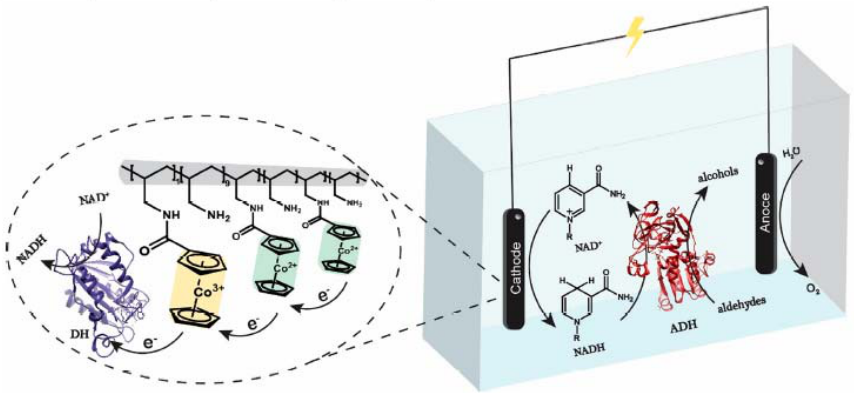
Figure 5. Schematic illustration of electro-enzymatic cofactor regeneration coupled with the reduction of aldehydes to alcohols. Reprinted with permission from Ref. [70]. Copyright © 2022 American Chemical Society.